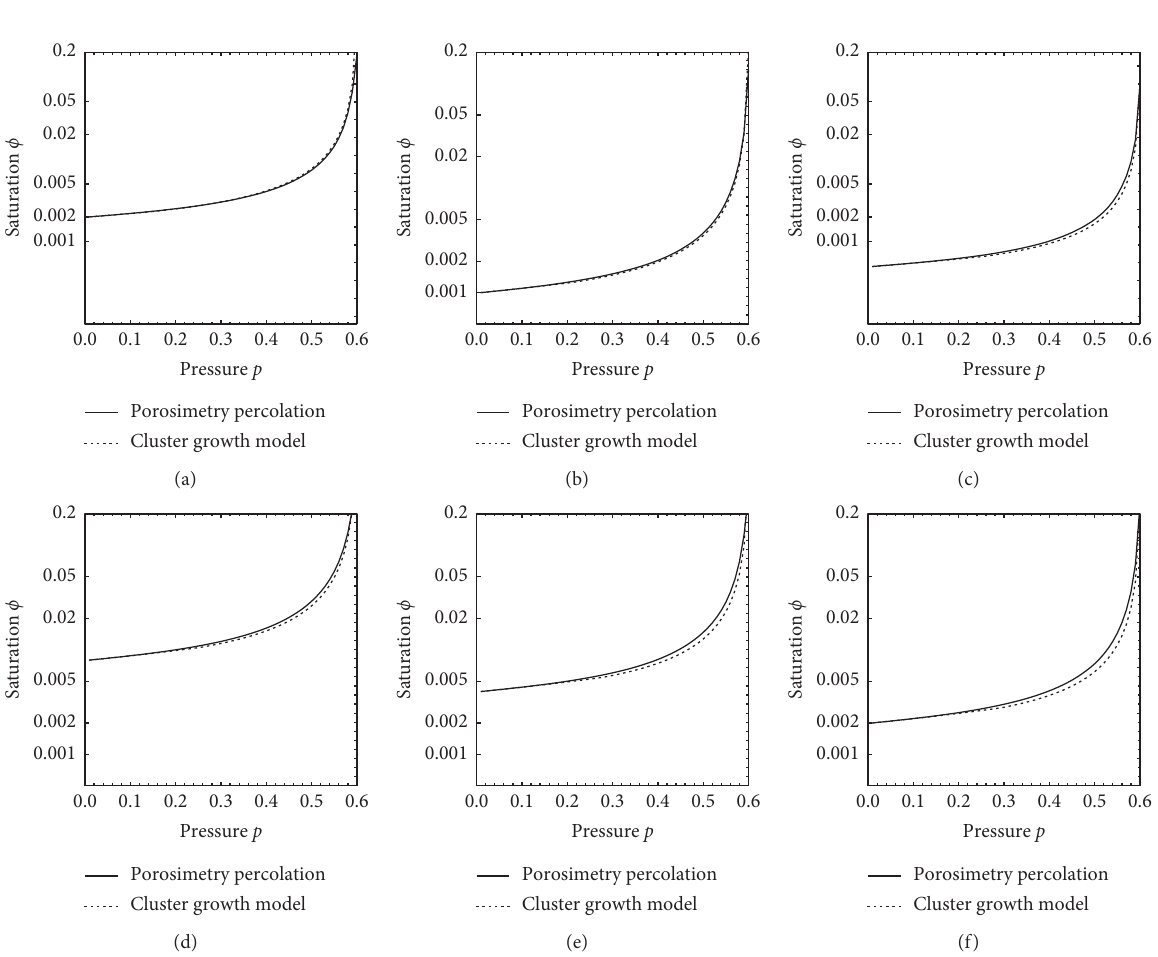
� 500, I � 500), (b) L � 1000 ( Φ � 1000, I � 1000), and (c) 0 0 0 0 � 1996, I � 1988), (e) L � 1000 ( Φ � 3996, 0 0 0 − Φ ) of the cluster growth calculation for 1-sided and 4-sided invasion cases. / Φ calc sim sim ��������������������� 􏽱 − Φ | / Φ (%) − Φ ) 2 1/ j 􏽐 ( Φ (%) / Φ calc sim sim calc sim sim